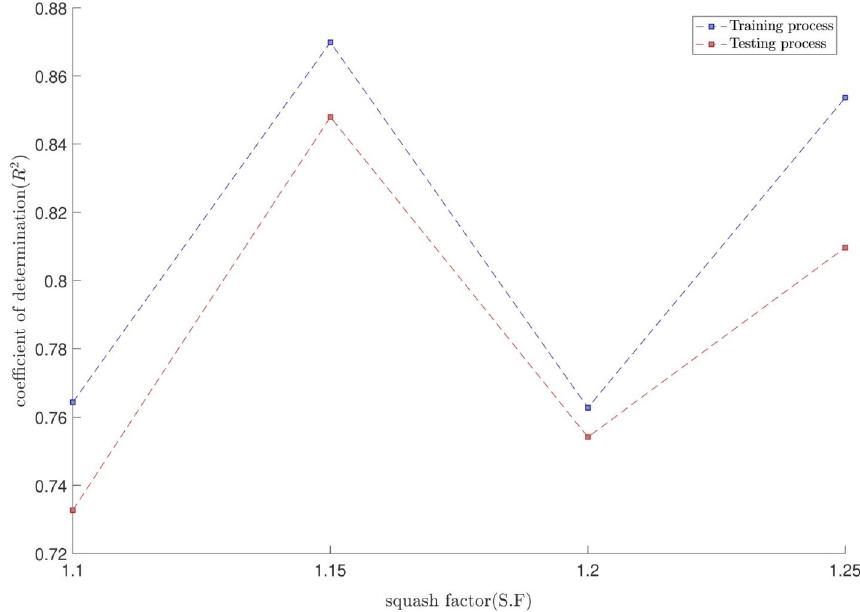
Figure 7. GAFIS method learning processes with changing in squash factor (S.F).